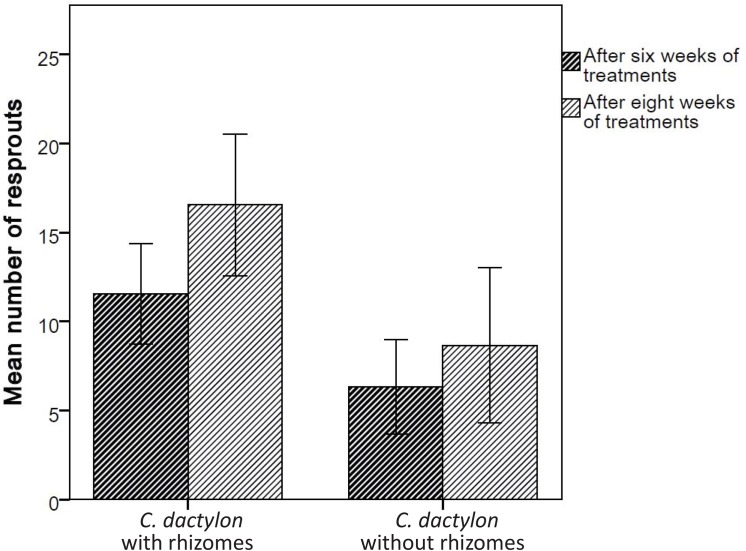
Emerging shoots.Mean number (±95% CL) of emerging shoots or resprouts for C. dactylon with rhizomes (left) and C. dactylon without rhizomes (right) after six weeks of treatments (dark hatched bars) and after eight weeks of treatments (light hatched bars).